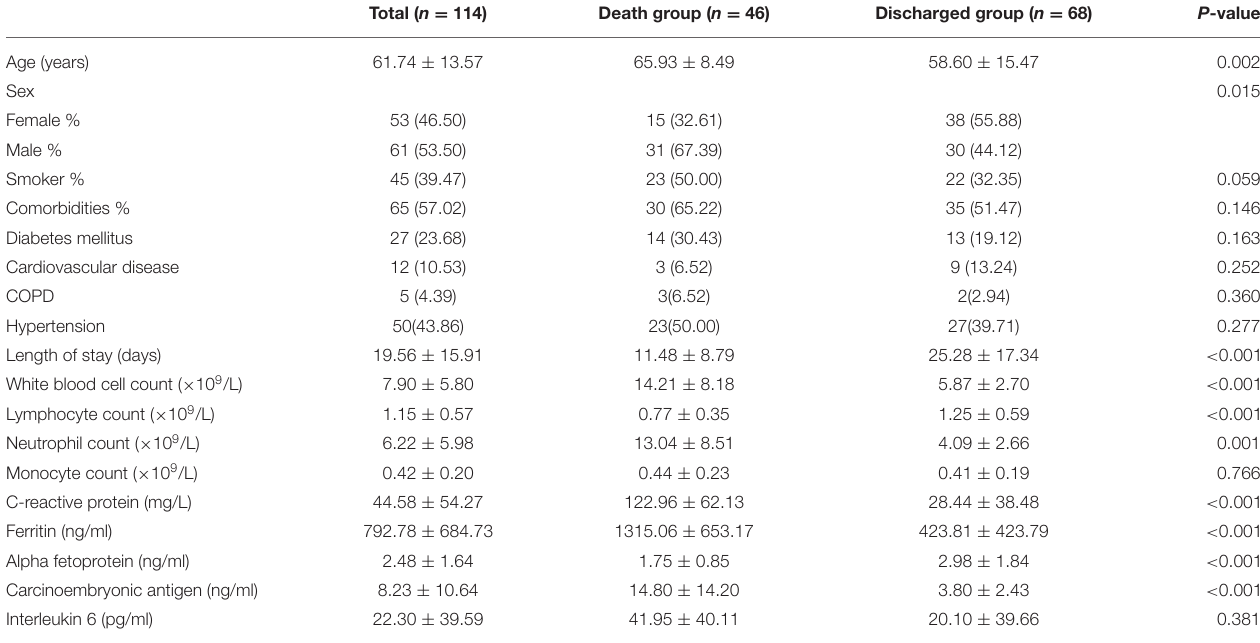
COPD, chronic obstructive pulmonary disease. Continuous variables are showed as mean ± SD.